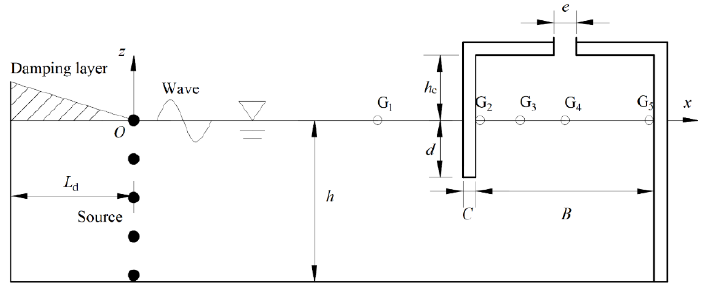
Figure 1. Sketch of the numerical wave flume with OWC-WECs. B denotes the chamber width, C the front-wall thickness, d the front wall draught, e the air duct width, hc the chamber height and h the static water depth. Five numerical wave gauges (i.e., G1, G2, G3, G4 and G5) are used to record the continuous surface elevations at different locations. G1 is situated outside the chamber at 1.0 wavelengths from the exterior surface of the front wall. Four gauges are situated inside the chamber: G2 is at the inner side of the front wall, G3 is 0.25 B from the internal side of the front wall, the third internal wave gauge, G4 is at the chamber center and G5 is at the rear